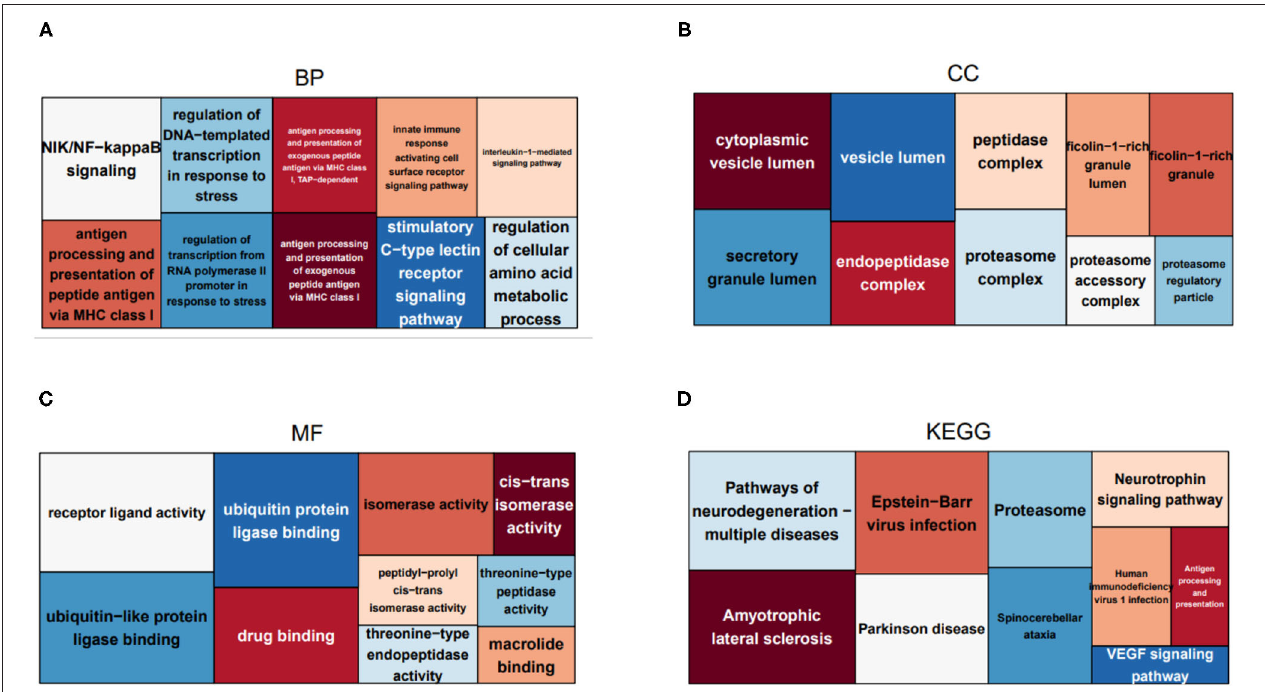
FIGURE 2 | Treemaps of GO and KEGG enrichment analysis, in which rectangle size is proportional to the statistical significance of functional annotations and pathways. (A–C) Treemaps of the enrichment analysis on GO biological process, cellular component, and molecular function, respectively. (D) Treemaps of enrichment analysis on KEGG pathways.